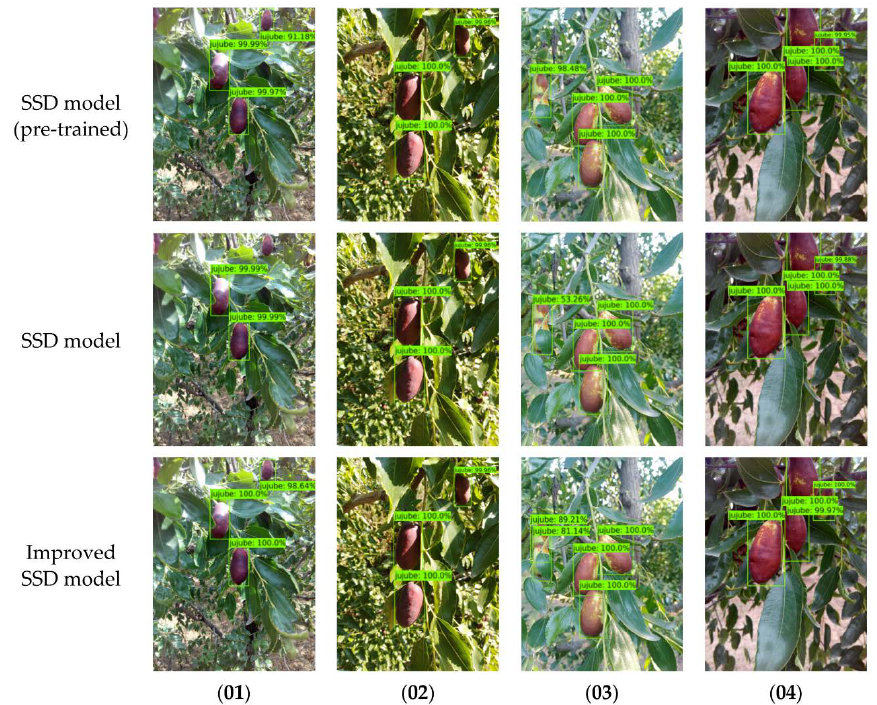
Figure 10. The comparison of the improved model and the original model. ( 01–04 ) The detection outcomes of the three